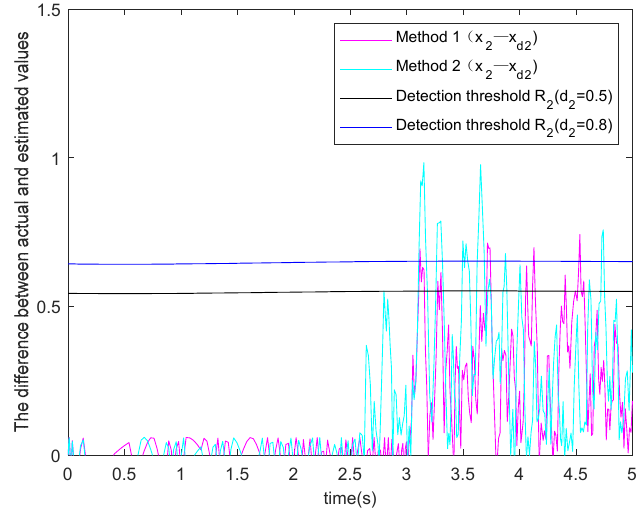
Figure 5. Interconnection fault detection of subsystem 2.